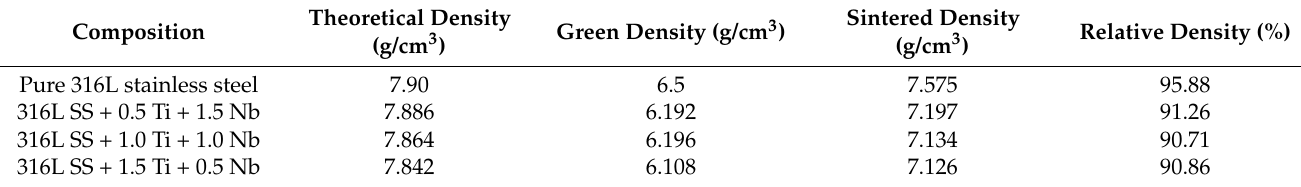
Table 3. Green and sintered densities of all compositions.